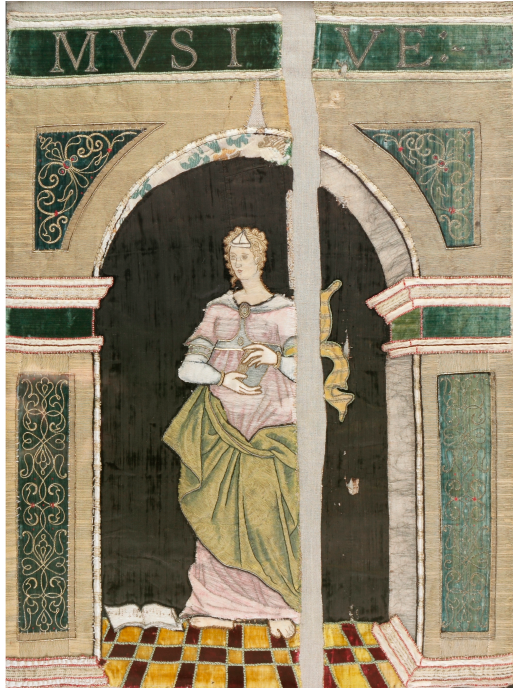
Figure 6. Anonymous, ‘MVSIQVES’ furnishing panel depicting the figure of Music with a music book, appliqué silk and velvet scraps with embroidery in couched gilt and silver-gilt thread and spangles in candelabrum and scrolling stem patterns over a linen base, second half of the sixteenth-century. National Trust: Hardwick Hall, Derbyshire. Object No. 1129552.